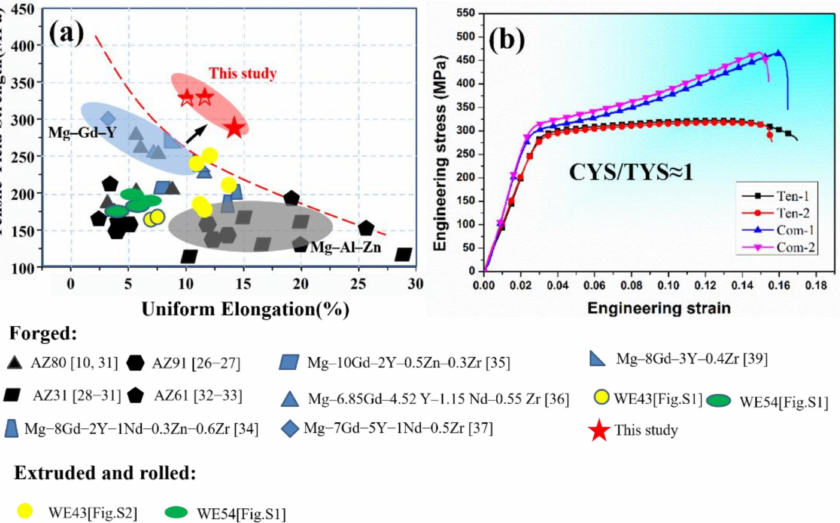
Figure 6. ( a ) Relationships between tensile yield strength and elongation of forged Mg-Al-Zn based and Mg-Gd-Y-based alloys as well as ( b ) tension-compression engineering stress-strain curves of MDIF100+100 sample of GW52